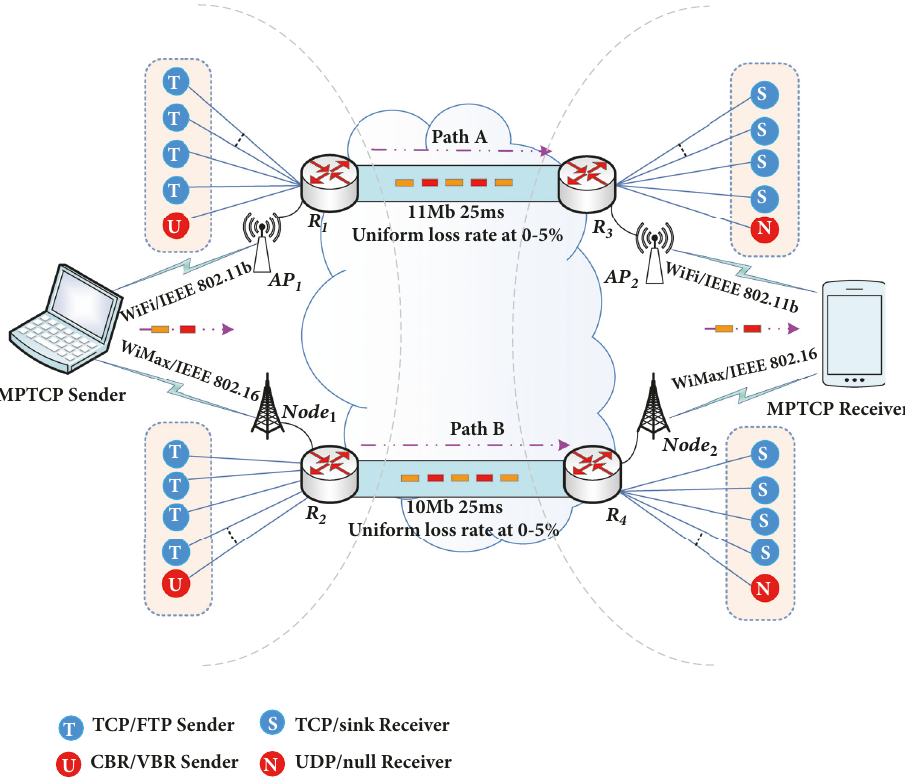
Figure 3: MPTCP-based simulation